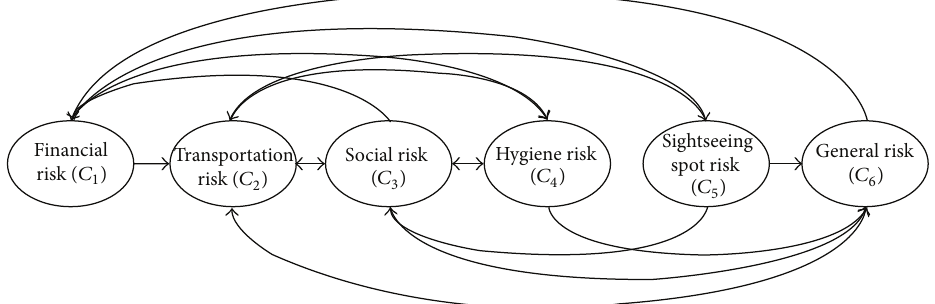
Figure 4: Interdependence criteria of research